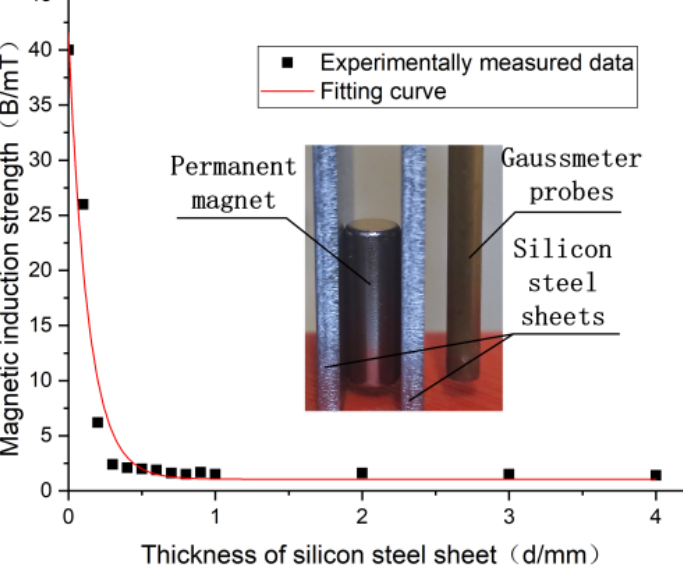
Figure 12. Variation curve of magnetic induction intensity with silicon steel thickness.